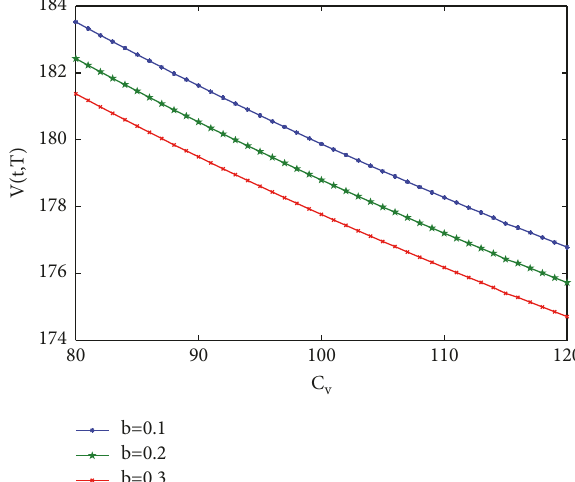
Figure 2: The warrant bond price with different 𝑆 0 .